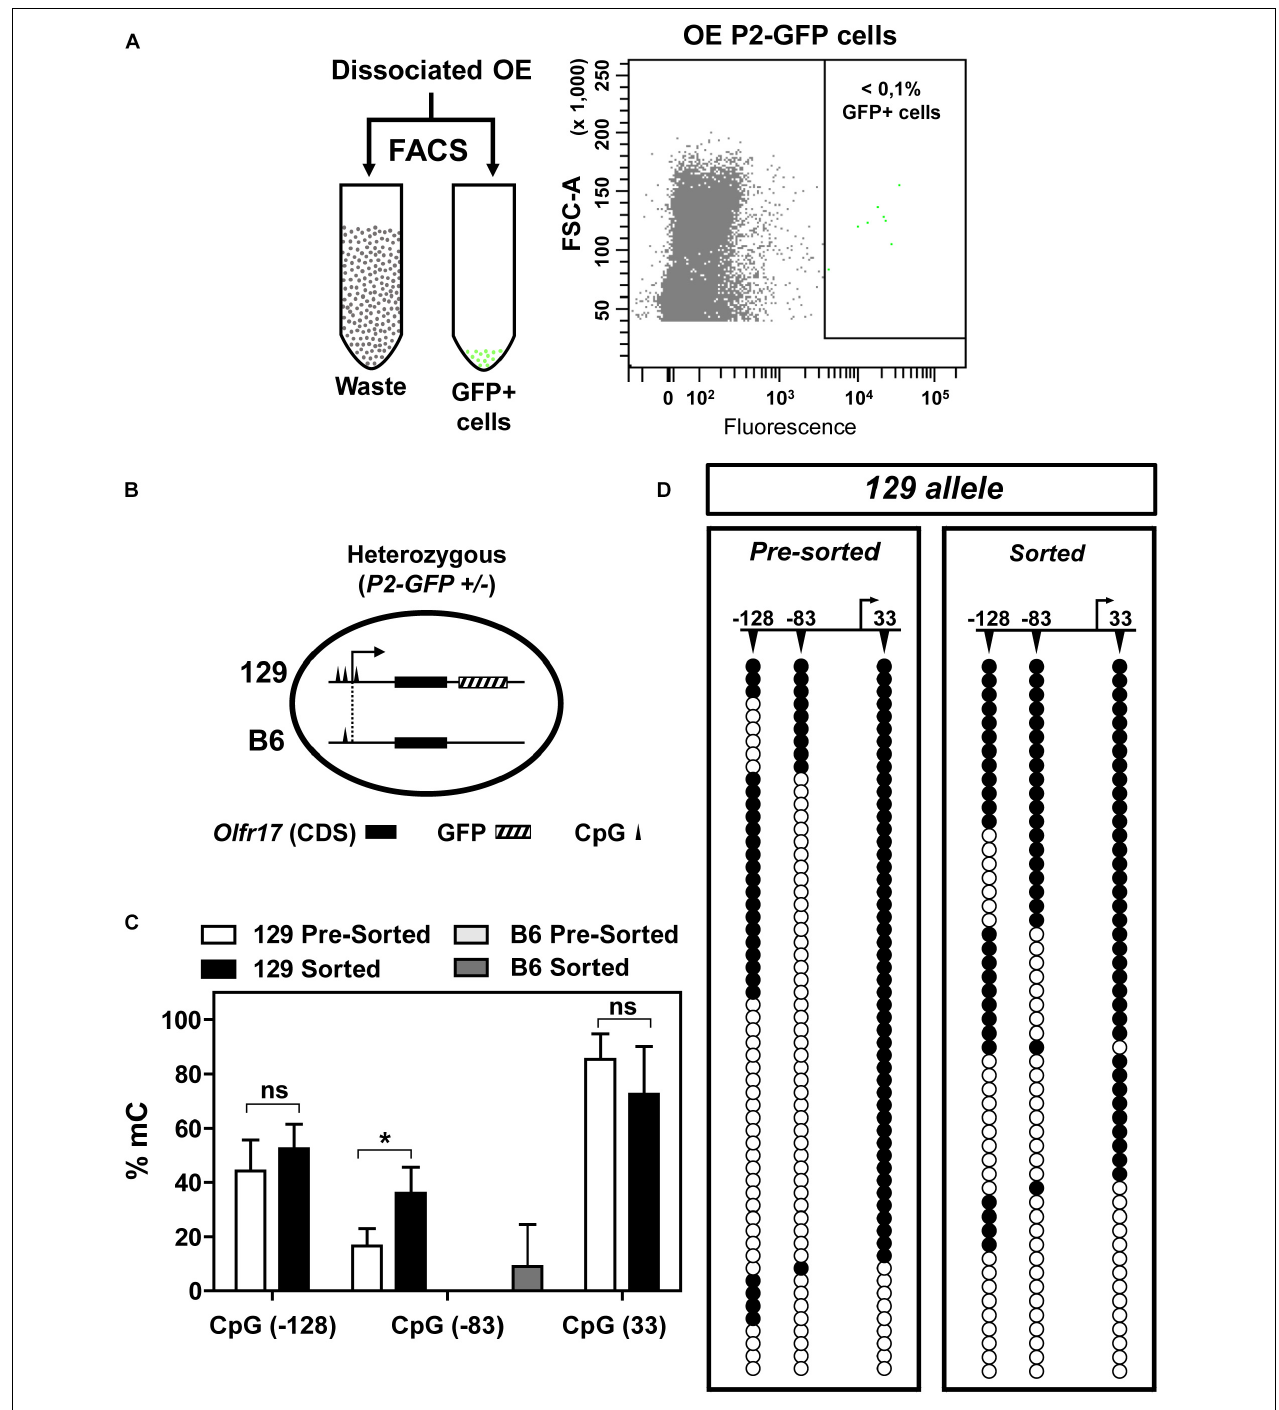
FIGURE 4 | DNA methylation in the 5 (cid:48) region of Olfr17 in GFP positive neurons. (A) Olfactory mucosa cells were dissociated from P2-GFP mice and submitted to fluorescence activated cell sorting (FACS) in order to isolate GFP+ neurons. The flow cytometry dot plot on the right was obtained when olfactory neurons from the P2-GFP mice were sorted, and the green dots within the square represent GFP+ neurons. (B) Schematic representation of the olfactory neurons sorted by FACS, showing that the cells from heterozygous knock-in mice contain one transgenic allele (129 Olfr17 allele) and one B6 Olfr17 allele. The vertical lines indicate the positions of the CpGs (–128, –83, and +33) in the promoter region and exon1. The 129 allele contains the three CpGs and the B6 allele contains only CpG –83. (C) Comparison of the Olfr17 methylation frequencies in pre-sorted and sorted neurons in both alleles. In the pre-sorted cells, CpG-83 in the B6 allele showed 0% methylation frequency. Student’s t -test, n = 3, * P < 0.05. (D) Distribution of the methylated CpGs in each sequenced clone from the 129 allele shown in the graph in (C) . Open and closed circles indicate unmethylated and methylated CpGs, respectively.